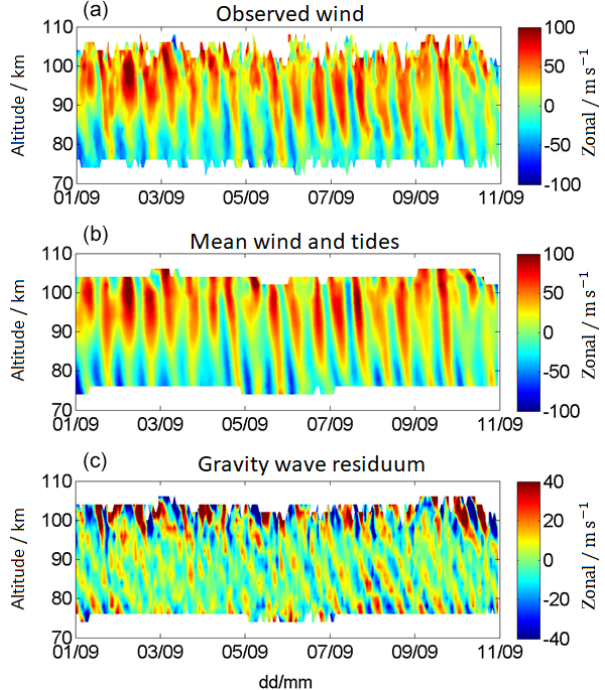
Figure 1. Decomposition of the observed wind (a) into the mean wind and tidal component (b) , and the gravity wave residuum (c) for Andenes 1–11 September 2017. Note the different labels of the color